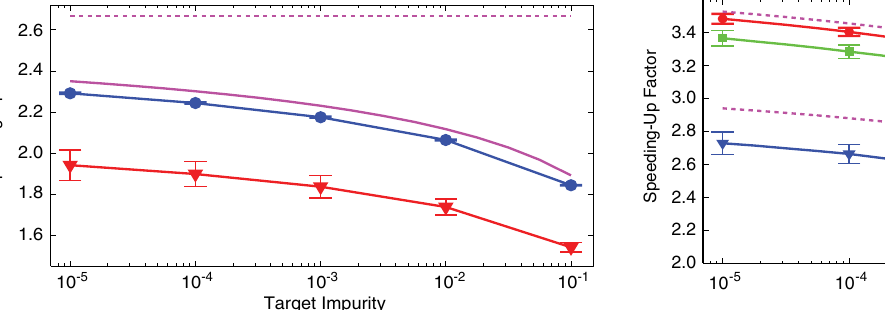
FIG. 6. Short-time numerically calculated speeding-up for D ¼ 4 . The dashed lines are the bounds on the speeding-up given by Eqs. (27) and (31). The circles, squares, and triangles are numerical calculations of the speeding-up with finite (cid:7)t ¼ 10 (cid:2) 3 (cid:2) (cid:2) 1 , 10 (cid:2) 2 (cid:2) (cid:2) 1 , 10 (cid:2) 1 (cid:2) (cid:2) 1 , respectively. In order to keep the error bars roughly the same size, the ensemble size was varied. The ensemble sizes for circles, squares, and triangles are 100, 400, and 6400,